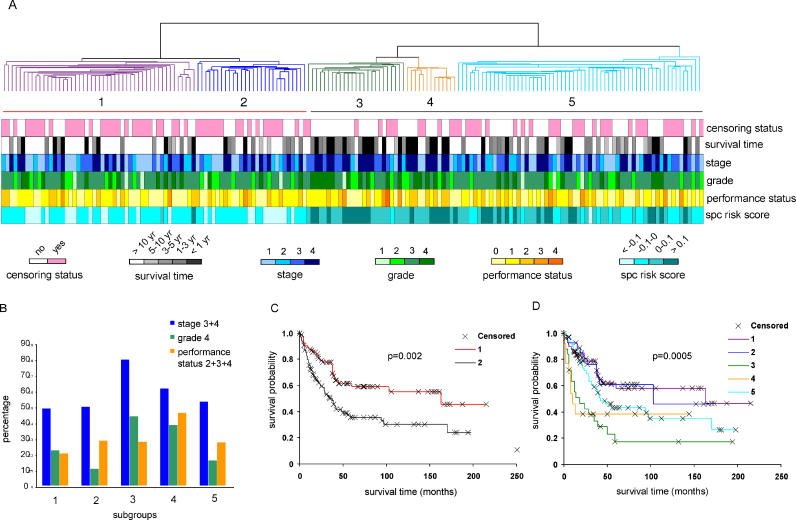
Relationship of Gene Expression Subgroups to Clinical Parameters and SPC Risk Score in 177 cRCCs(A) Dendrogram from the hierarchical cluster, with the clinical information for each of the samples. Subgroups are color-coded as in Figure 1. Color shade corresponds to the ranges of each of the clinical parameters displayed. Expected survival times for the censored observations were estimated from the Kaplan-Meier curve for all patients.(B) Distribution of stage, grade, and patient performance status among five subgroups.(C) Kaplan-Meier estimates of disease-specific survival in the two main gene expression groups of patients (subgroups 1 and 2 shown by the red bar below the dendrogram, compared to subgroups 3, 4, and 5 designated by the green bar).(D) Kaplan-Meier estimates of disease-specific survival in the five subgroups of patients.The X symbols in (C) and (D) denote censored data.